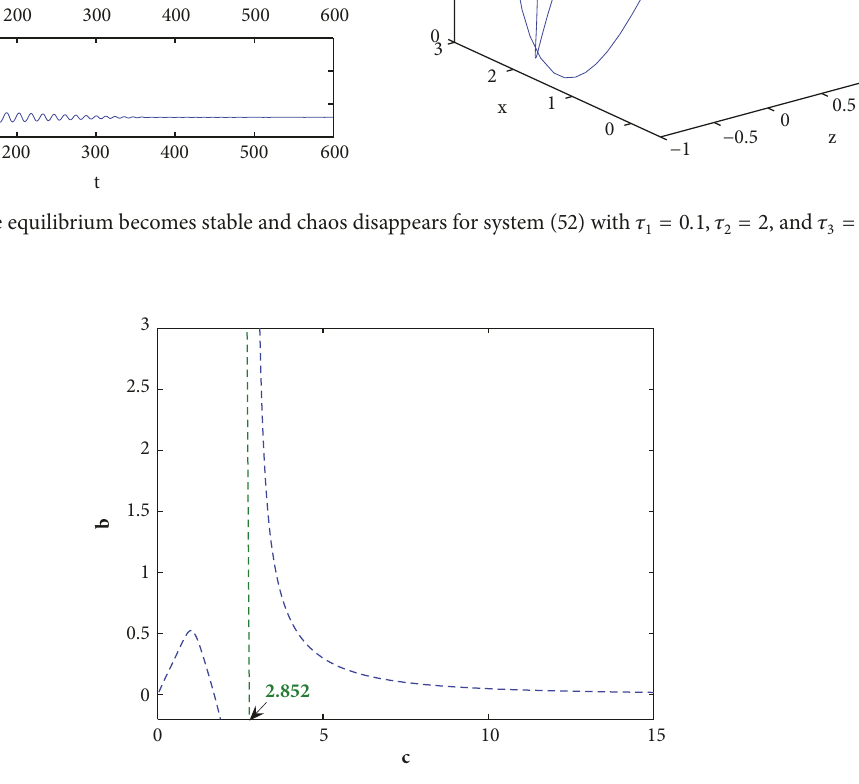
Figure 13: The bifurcation curve in (c,b) plane for system (1) with 𝑎 = 0.9